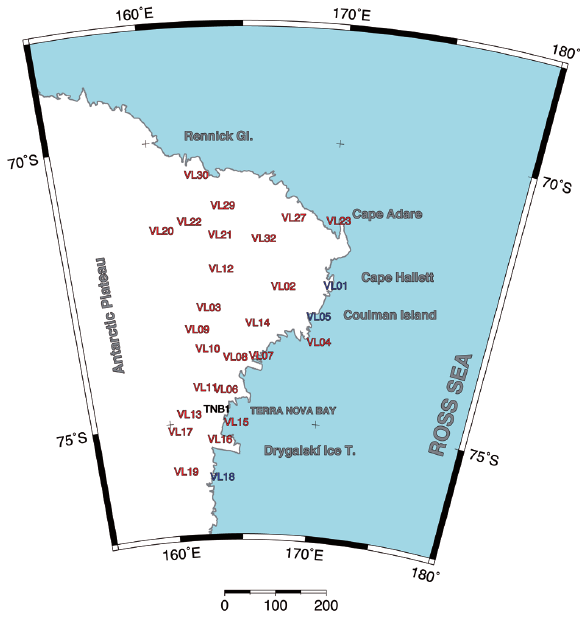
Figure 2. Map of the location of TNB1 and the VLNDEF network sites. VL01, VL05 and VL18 (blue) are semi-permanent GPS sta- tions. The scale of the distances shown under the map is in